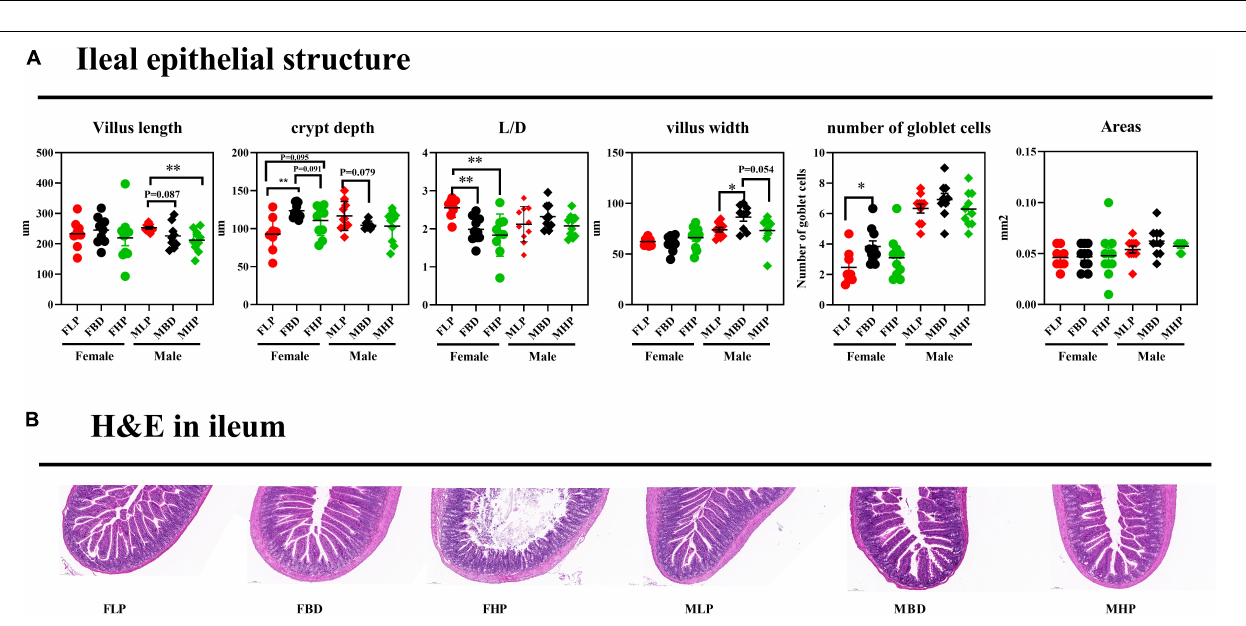
FIGURE 3 | Effects of diets with different protein levels on the morphology of jejunal epithelial tissue in mice. (A) The structure of the jejunal epithelial tissue. (B) Light microscopy cross-section of jejunal tissue.